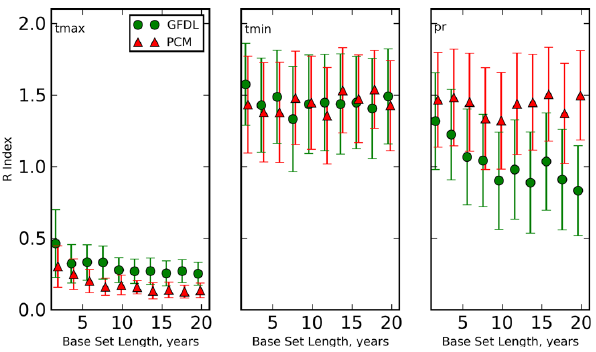
Fig. 12. Similar to Fig. 10, but using an extended observational base period and GCM